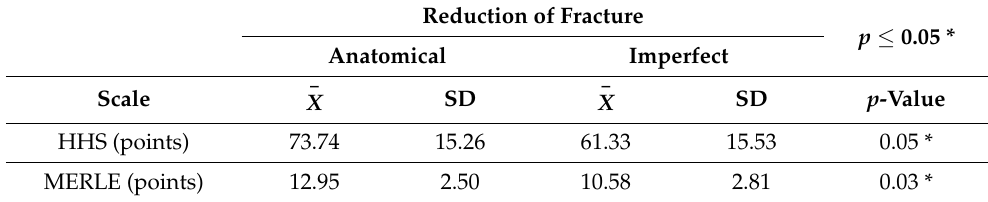
Table 4. Functional state and the reduction of the fracture.